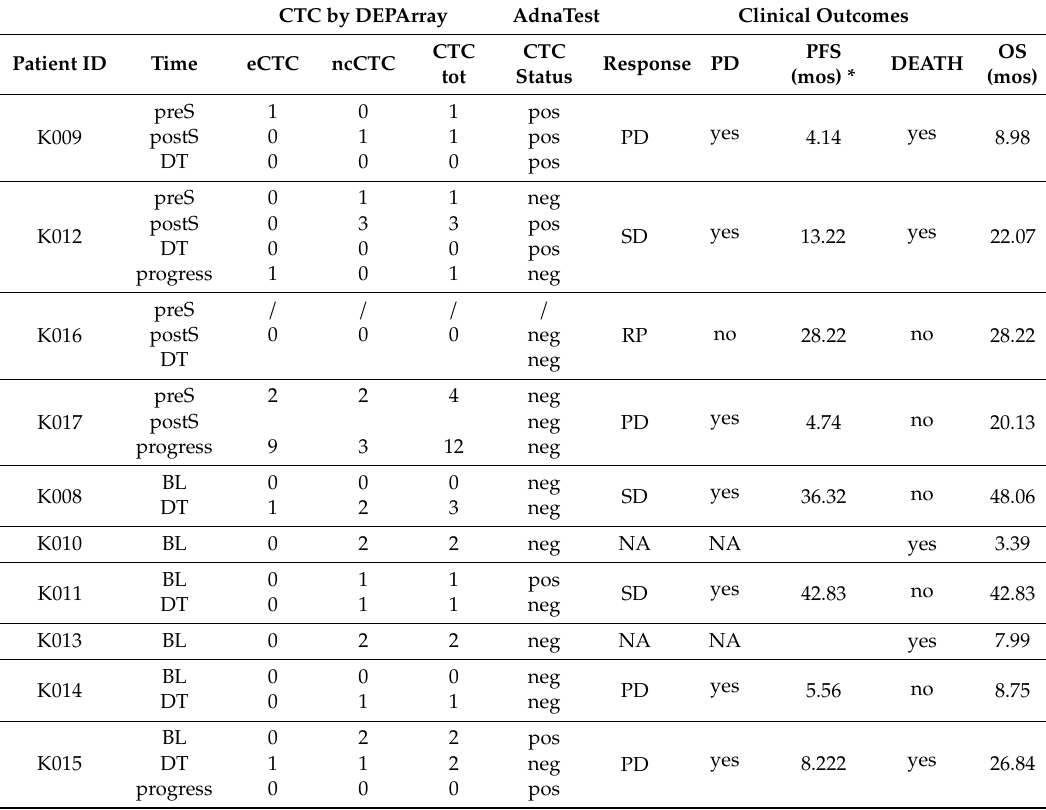
Table 1. CTC and treatment response data in the TARIBO case